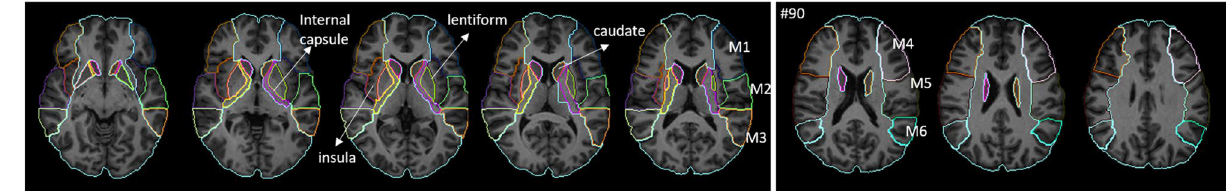
Figure 2. The ASPECTS ATLAS. The regions of interest (ROIs) are overlaid in the template